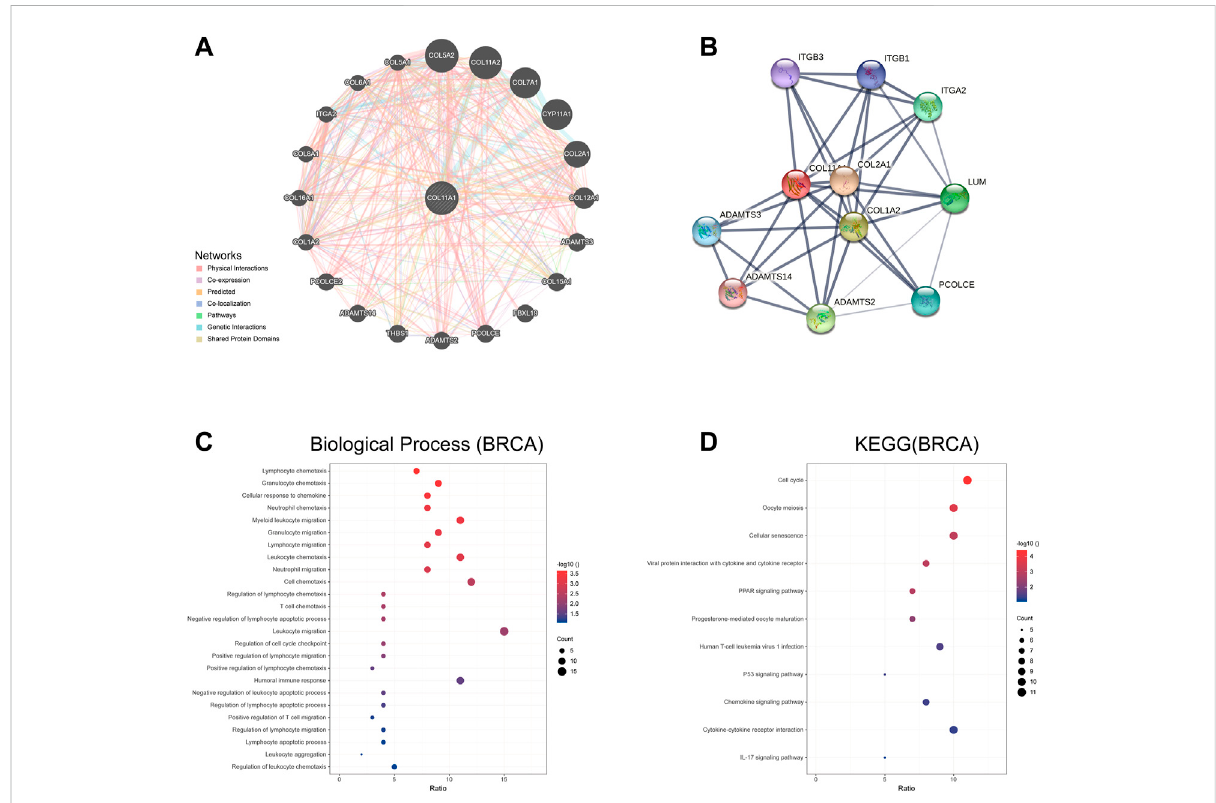
FIGURE 4 The genes and protein interaction network of COL11A1 (A) The gene-gene interaction network of COL11A1 was constructed using GeneMania. (B) The PPI network of COL11A1 was generated using STRING. (C) A bubble chart shows the GO analyses of 24 COL11A1 correlational genes. (D) A bubble chart shows the KEGG analyses of 24 COL11A1 correlational genes. * p < 0.05, ** p <